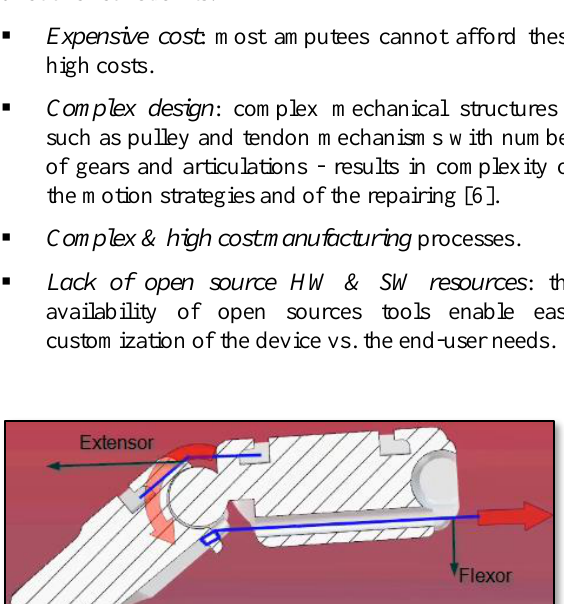
Dimensions and shape of the phalanges of the fingers